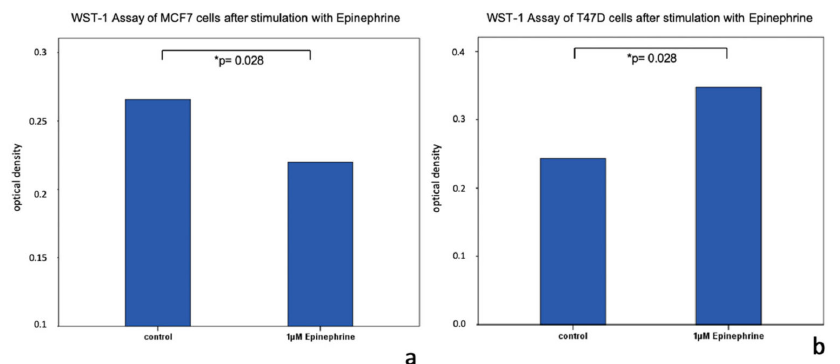
Figure 5. WST-1 assay of MCF7 and T47D cells stimulated with epinephrine. ( a ) Bar chart of optical density of MCF7 cells after incubation with 1 µ M epinephrine for 48 h. Epinephrine induced a decrease of cell proliferation ( p = 0.028; * significant p -value). ( b ) Bar chart of optical density of T47D cells after incubation with 1 µ M epinephrine for 48 h. Epinephrine induced an increase of cell proliferation ( p = 0.028; * significant p